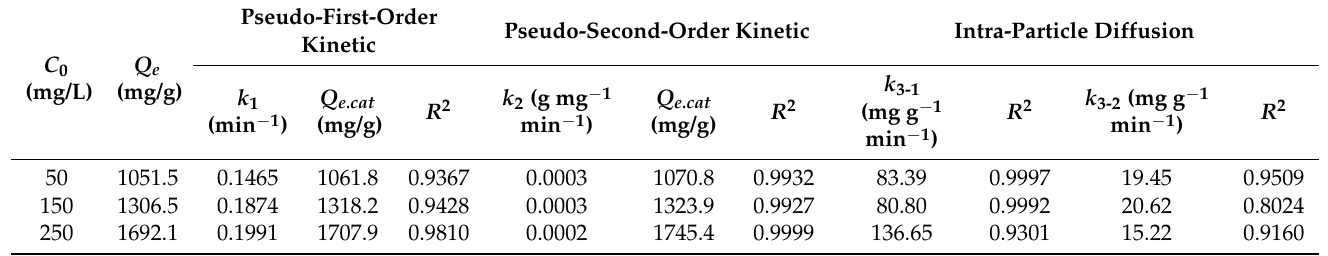
Table 2. Fitting parameters of the adsorption kinetic models.